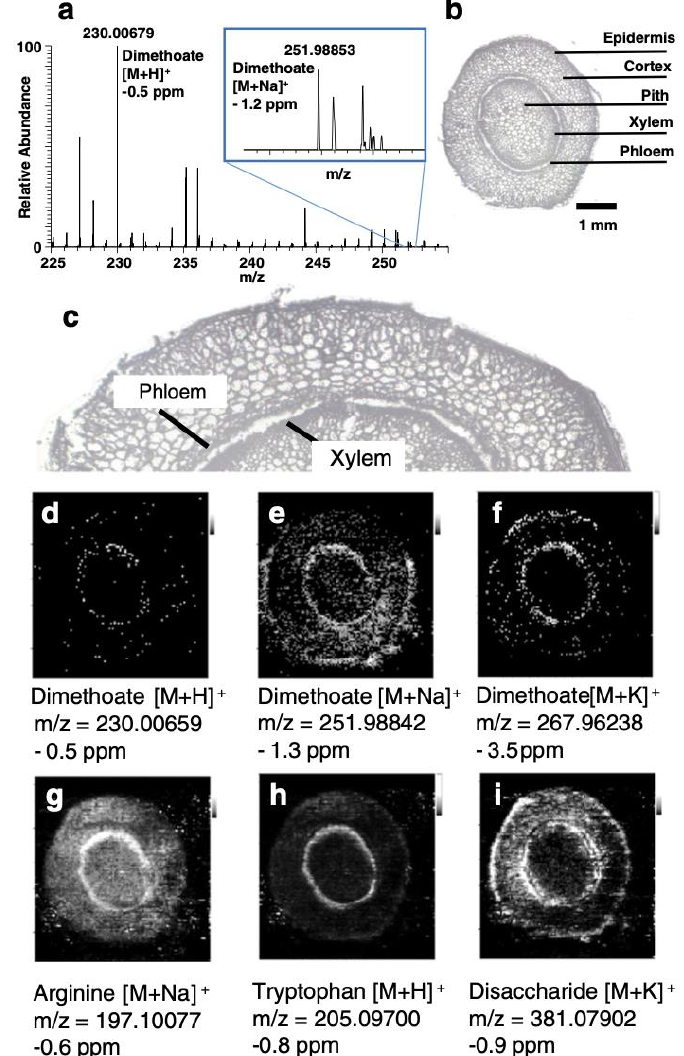
Figure 6. Images obtained from the dimethoate experiment on Kalanhoe blossfeldiana to see root uptake: ( a ) DESI mass spectrum of protonated dimethoate and sodium adduct detected in spiked soil; ( b ) Optical image of Kalanchoe stem cross-section; ( c ) Enlarged area of stem section to improve visualisation of xylem and phloem area; ( d – f ) Distribution of dimethoate in the plant stem, detected as protonated species, sodium and potassium adduct; ( g – i ) DESI-MS images of different naturally occurring substances. Pixel size of the DESI-MSI experiment was set to 60 µ m. Figure reproduced with permission from Gerbig et al. [133].